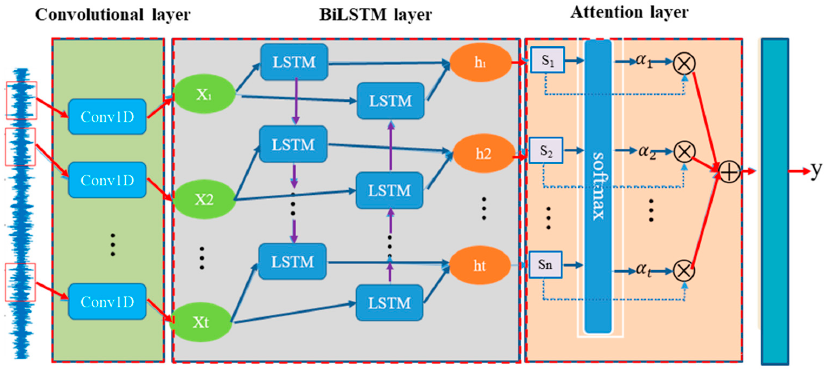
Figure 4. The proposed hybrid neural network fault detection method.